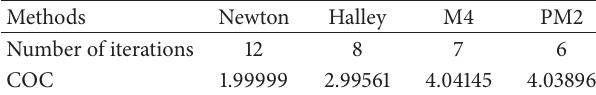
Table[A[l] = RandomReal[ { -5, 5 } , { n, n } ];, { l, number }